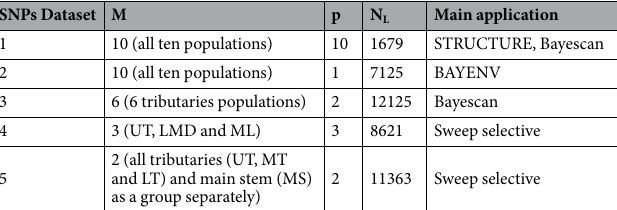
main mtDNA haplotypes that corresponded to the tributaries and main stem, with no haplotypes shared between them. Among the tributary groups, one haplotype was shared among the three populations (CW, XYG and QNT) from the UT and one population (LMD) from MT in the tributary group, and one haplotype was shared by DLB and PH in the main stem. The main stem populations were characterized by high haplotype diversity (Table S1). RAD tag genotyping. A total of 697.2 million reads were derived from three pooled libraries that included 196 individuals. The mean number of reads per individuals was 3,557,185 ( SD = 1921,313, range 247–13456,369). Of these reads, an average of 79% ( SD = 12%, range 7–96%) carried the complete recognition site of BcgI enzyme. Raw sequencing data are available at BioProject SRP079503. After exclusion of samples with few reads or few goal reads, the remaining 190 samples were used for the following analysis. The average number of stacks per individual was 47,076 ( SD = 11,508, range 5,733–116,580), with the mean coverage per stacks ranging from 21 to 161X per individual. After merging of all the stacks from each individual, the final catalog contained 222,116 loci, of which 148,909 contained at least one SNP (92.3% biallelic, 6.4% triallelic, and 1.3% tetrallelic). Four SNP datasets (Table 2), with at least 80% of the individuals for all populations at > 5X coverage per allele, were included in the following population analyses. Population structure analysis. (Table. 1) in the up-tributaries (UT: QNT, GZ, CW and XYG) belonged to cluster 1 (in red), most specimens in the MS (LK, DLB, DG and LK) belonged to cluster 2 (in green), and most individuals in the low-tributary (LT: ML) belonged to cluster 3 (in blue). Clusters 1 and 3 both existed in the mid-tributary (MT: LMD) and exhibited almost equal average probabilities of membership. This arrangement was also indicated by the principal coordi- nate analysis (PCoA) plot (Fig. 2c) using the same dataset as that used in the STRUCTURE analysis, wherein the populations formed a distinct group along PCO 1. It was clear that four clusters (UT, MT, LT and MS) existed in the ten populations, and populations with close geographical distances always clustered together. Furthermore, LT and MT formed two distinct group, respectively. and MT was intermediate between LT and UT, thus indicat- ing that MT might be a transition state of LT and UT. Together, the results indicate that the ten populations have a three-cluster genetic structure (comprising UT, MS and LT, and MT is an intermediate form between UT and LT). The hierarchical AMOVA among the four clusters (UT, MT, MS and LT) resulted in Φ ST = 0.82 ( P < 0.001), indicating a very high level of genetic structure. A signal for isolation by distance was detected ( r = 0.83, P < 0.001, Mantel’s test) among the ten populations. The results of the AMOVA and isolation by distance test revealed a